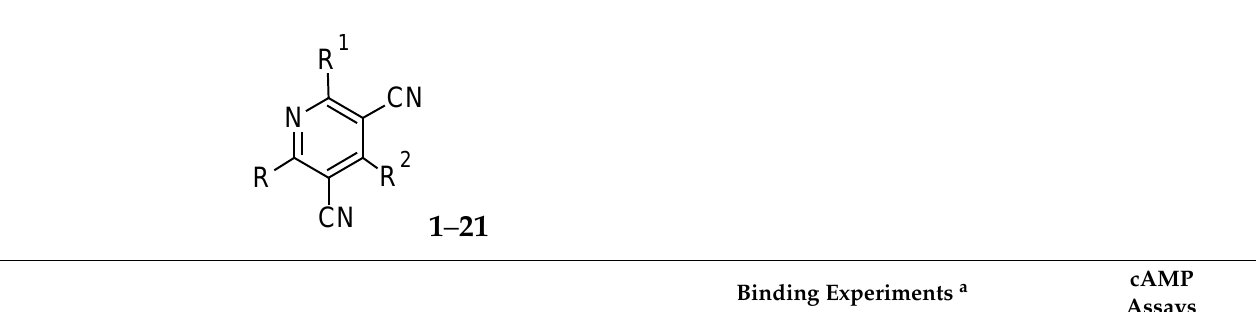
Table 1. Binding affinities ( K i ) at hA 1 , hA 2A and hA 3 ARs and potencies (EC 50 ) at hA 2B ARs.